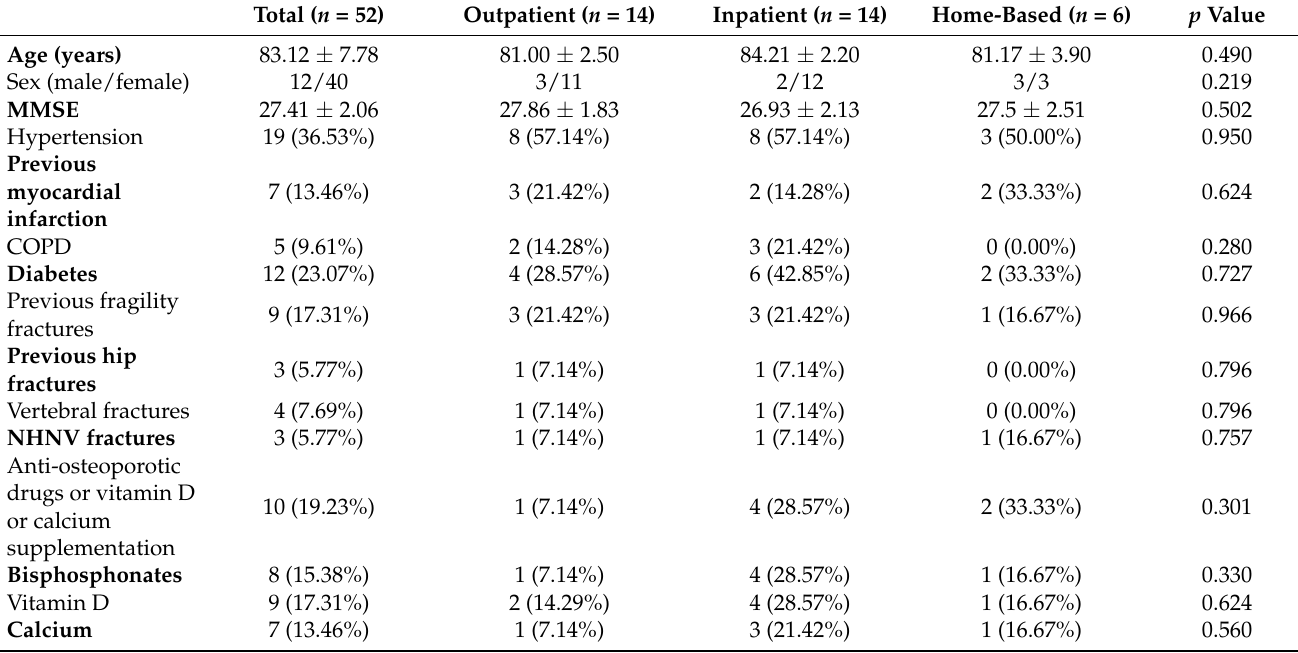
Table 1. Sample baseline